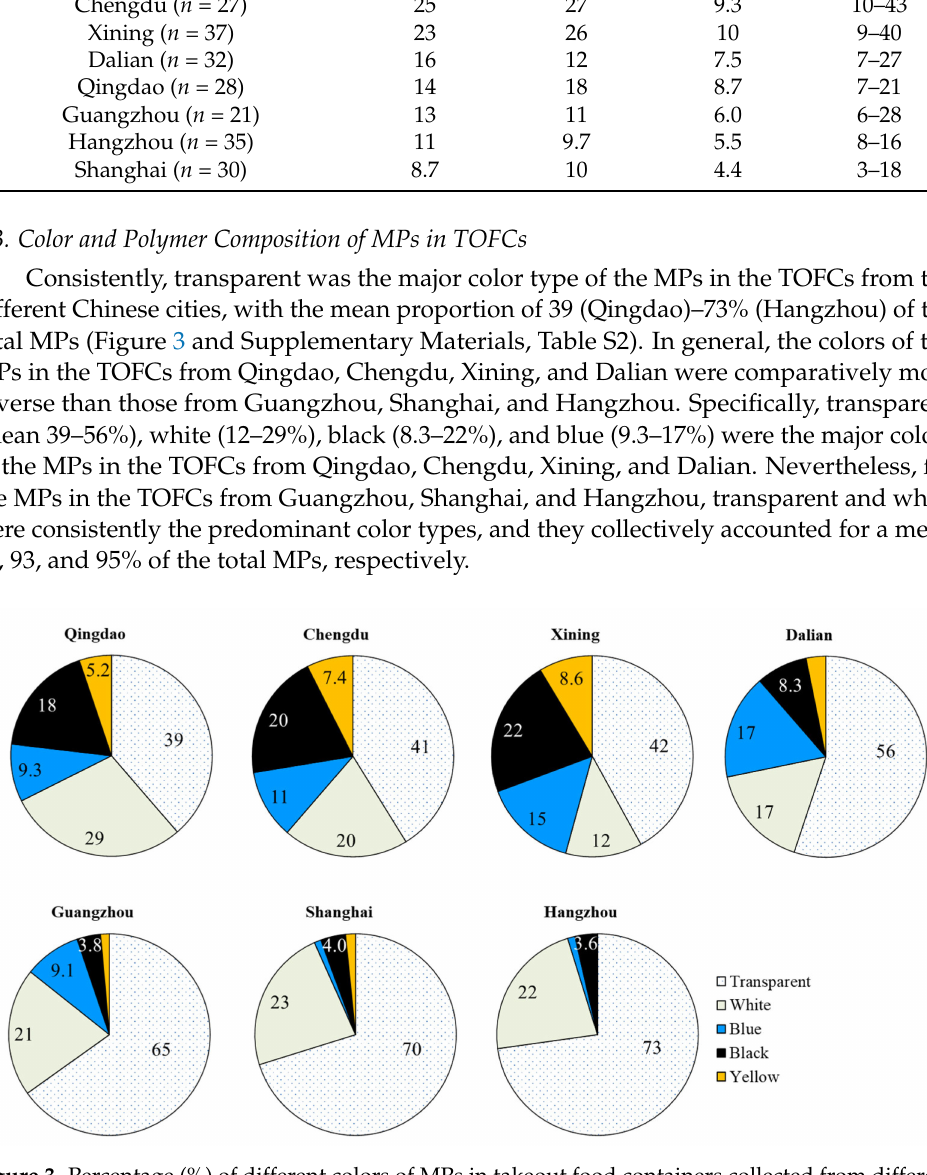
Figure 3. Percentage (%) of different colors of MPs in takeout food containers collected from different Chinese